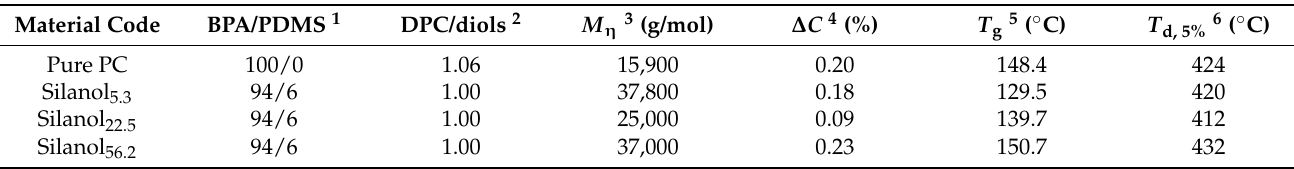
Table 6. Polymerization of silanol copolycarbonates with different chain lengths of PDMS and BPA as two different diols and DPC as the carbonate source.